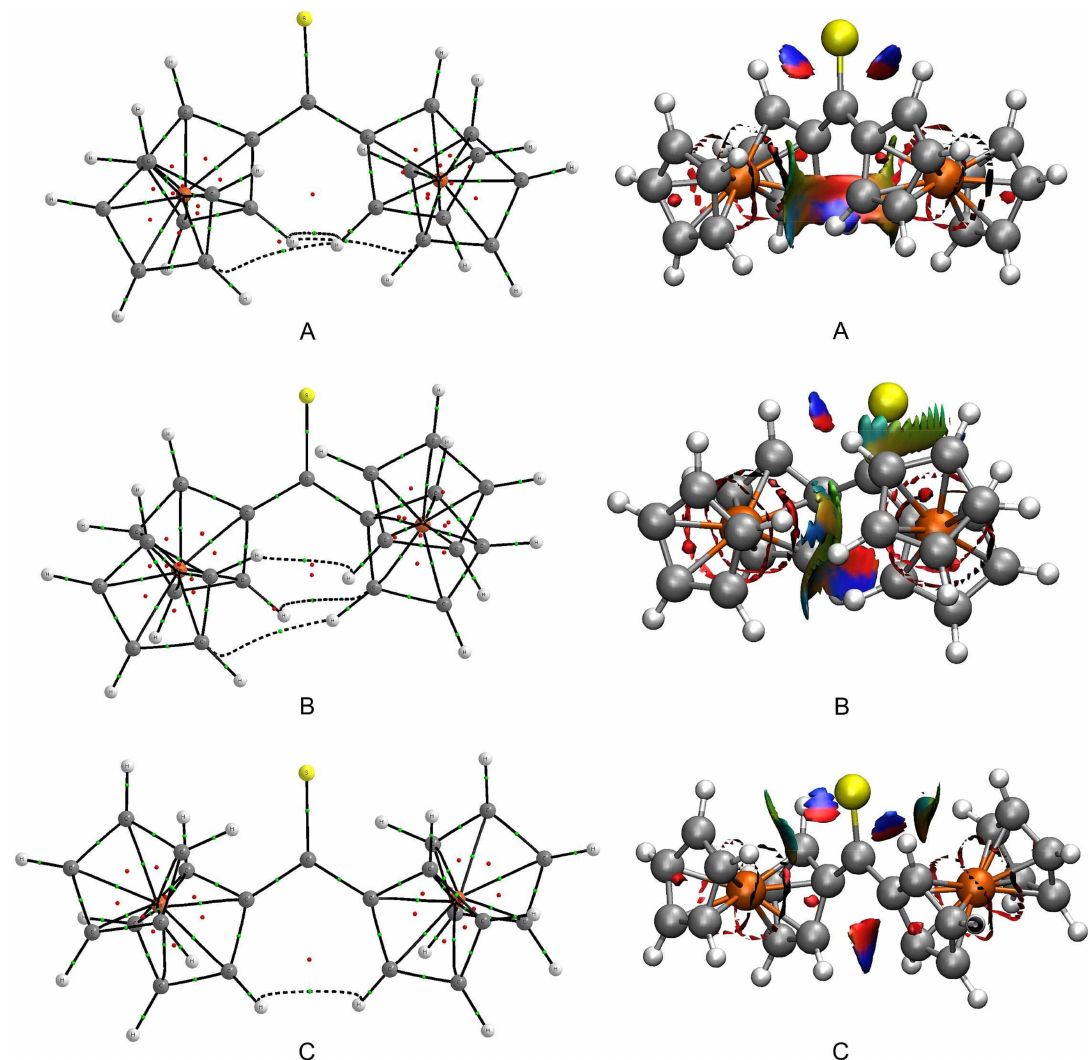
Figure 5. QTAIM molecular graphs and NCI plots for three rotamers ( A – C ) of an isolated Fc 2 CS molecule. Bond paths are shown as black lines and their critical points are marked with small green balls. Ring critical points are denoted by small red balls. The bond paths associated with the interactions between the Fc groups are drawn with black dashed lines. The NCI isosurfaces are plotted with a reduced density gradient isovalue of 0.5 a.u. and they are colored from blue to red according to sign( λ 2 ) ρ ranging from negative to positive values, respectively. Colors coding individual elements and numbering of atoms are the same as in Figure